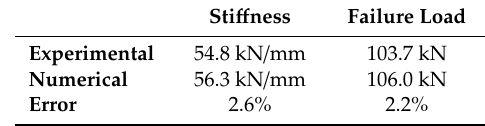
Table 3. Numerical-experimental comparisons: Sti ff ness and failure load.